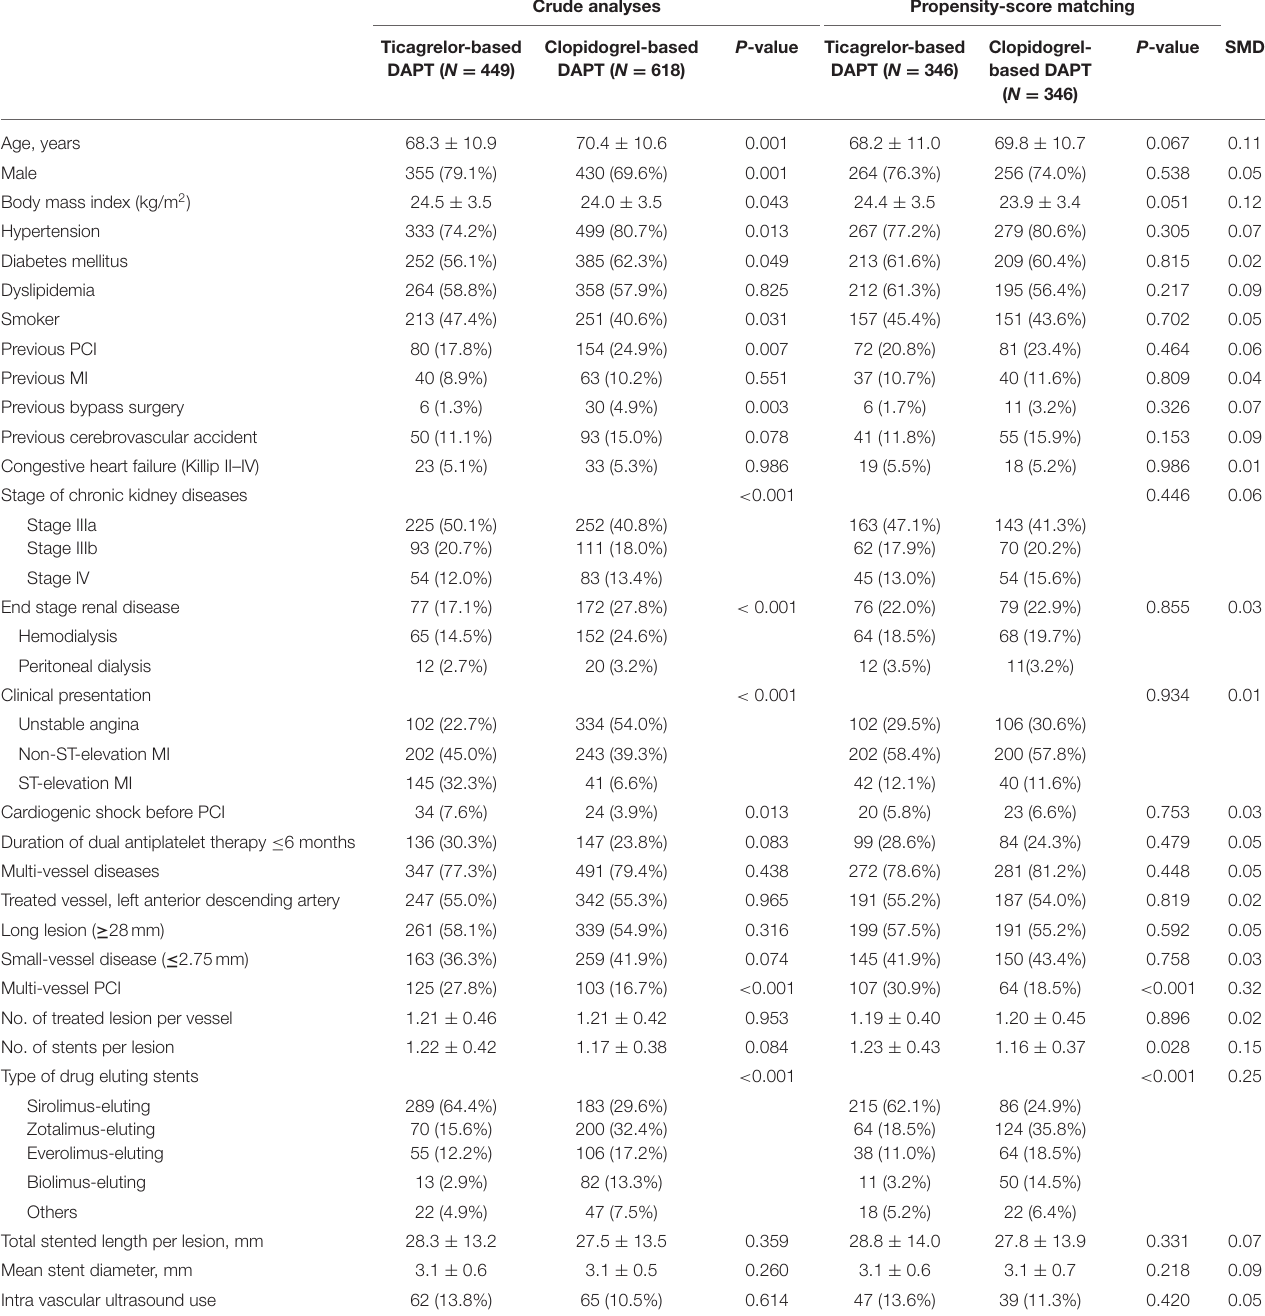
TABLE 1 | Baseline